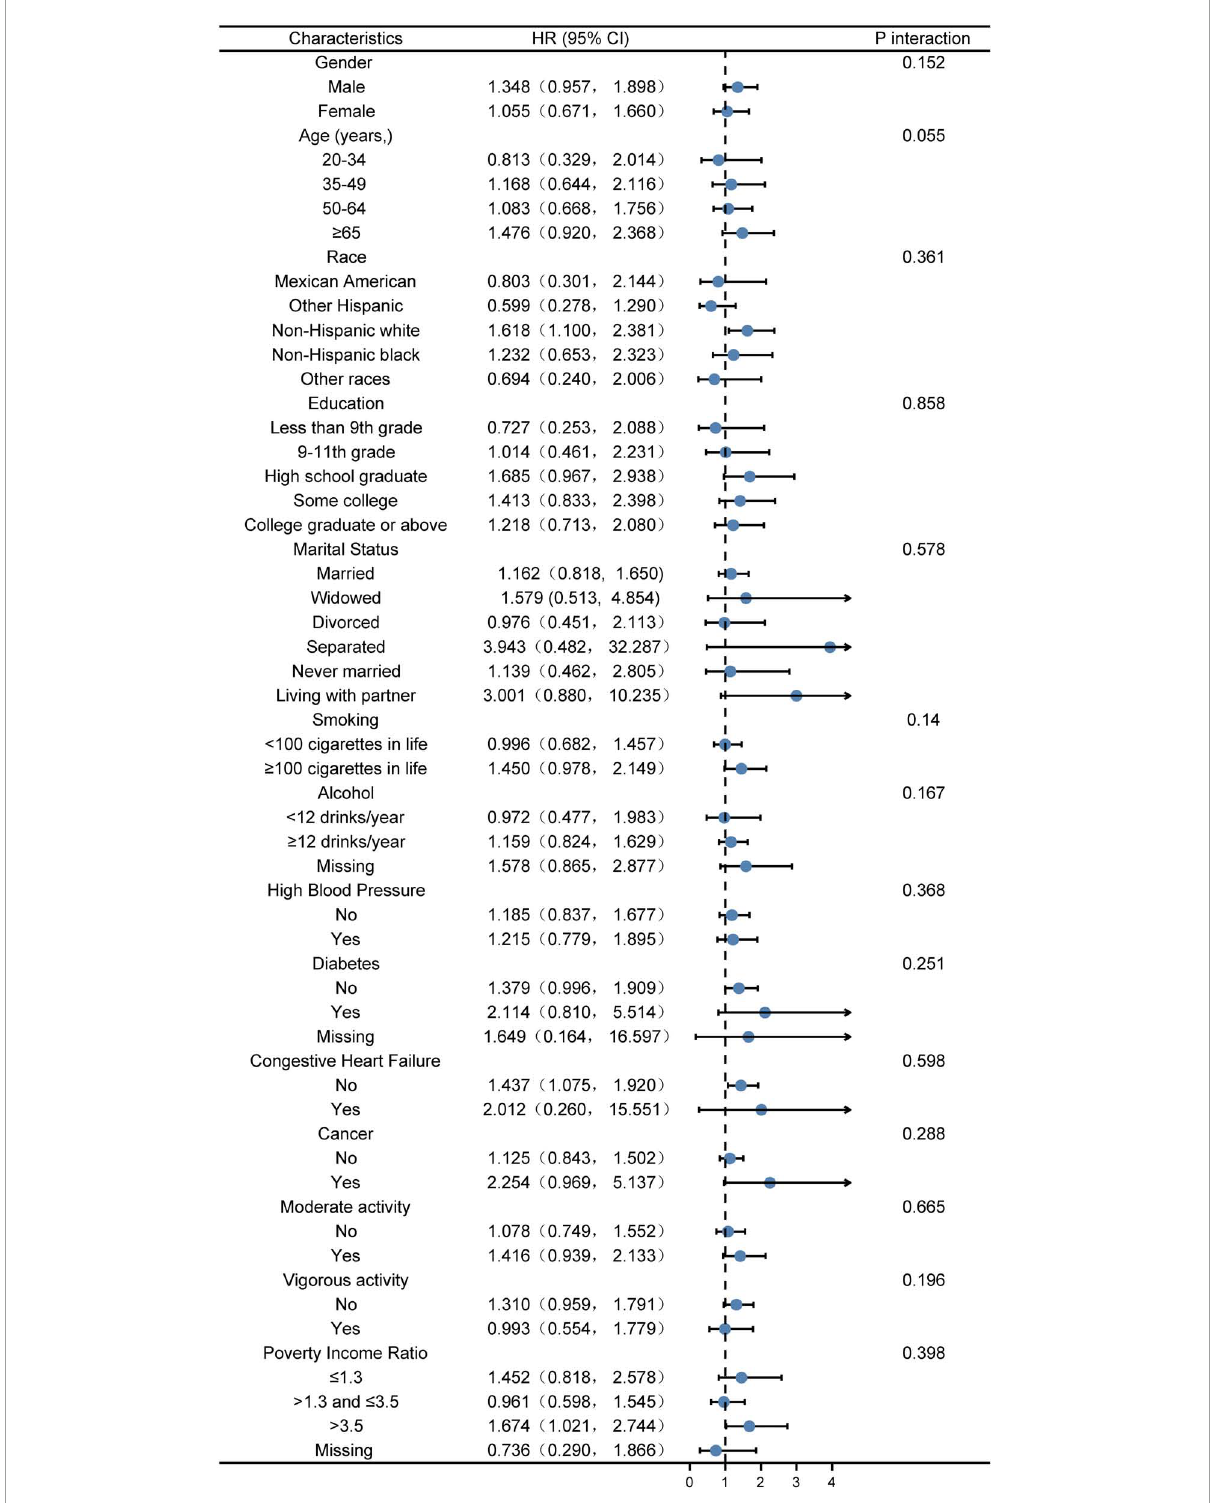
FIGURE2 Stratified logistic regression analysis to identify variables that modify the correlation between VAI and kidney stones A subgroup and interaction analyses with VAI as a categorical variable (divided into quarters), for the part of VAI < 75.130, compared Q4 with Q1. Adjusted for gender, age, race, poverty income ratio, education, marital status, smoking, alcohol, vigorous activity, moderate activity, diabetes, HBP, CHF, cancer, energy, and HEI2015 total score. The model is not adjusted for the variable itself in each